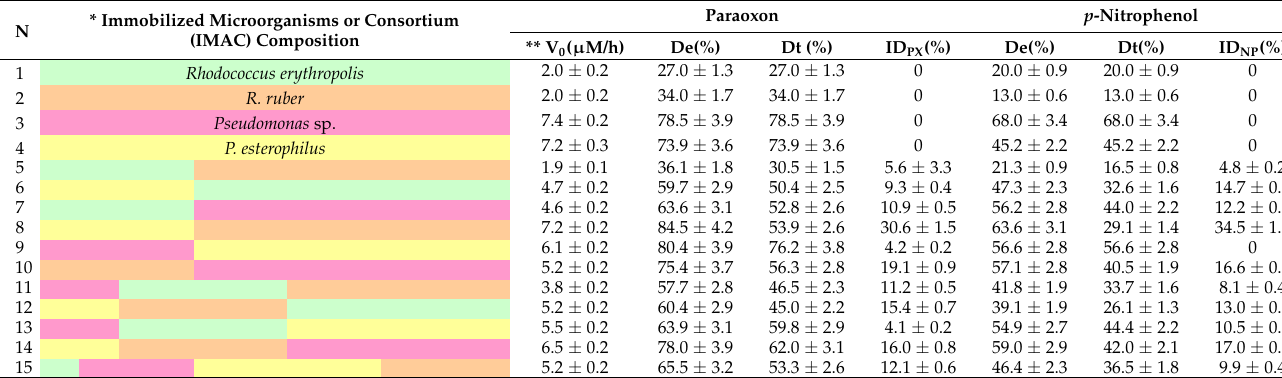
Table 1. Results of paraoxon or p -nitrophenol degradation (0.15 mM) under the action of immobilized bacterial cells or various variants of IMAC (20 g wet